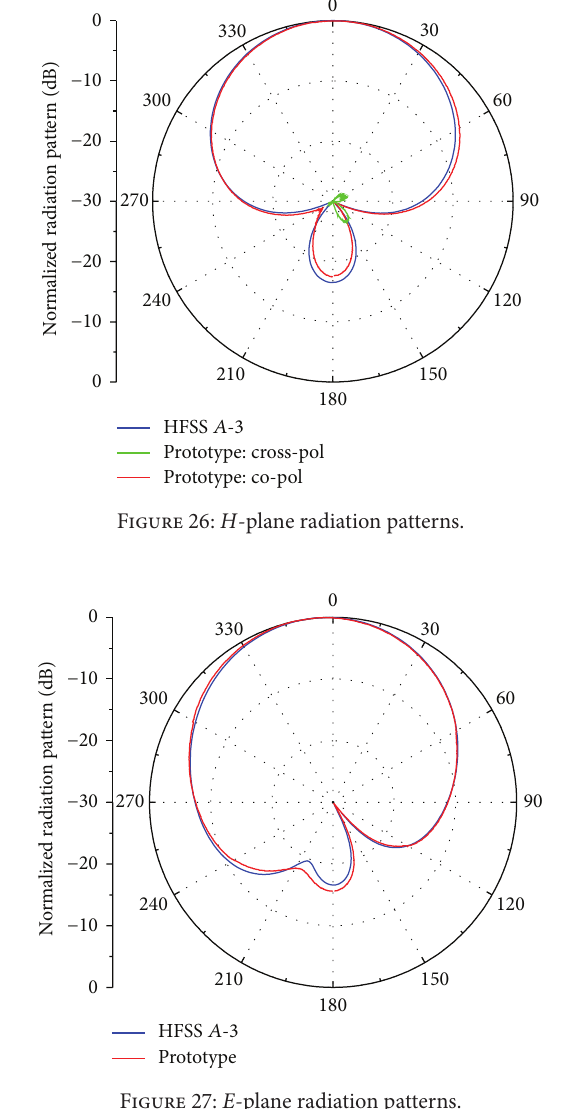
Figure 27: E -plane radiation